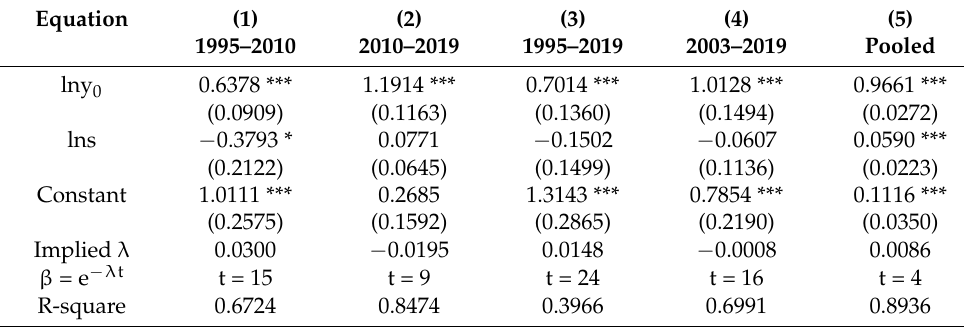
Table 3. Conditional Convergence Test of Cross-Sectional